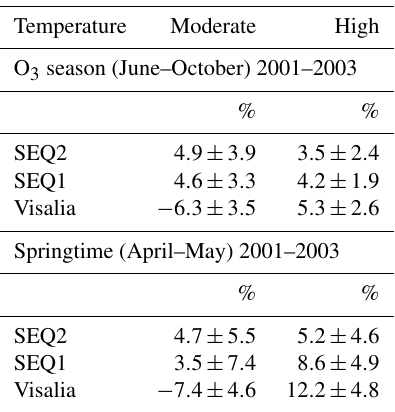
Table 1. Percent difference in afternoon (12:00–18:00LT) O x or O 3 on weekdays and weekends calculated as ( O x, weekday − O x, weekend )/ O x, weekday in Visalia, SEQ1, and SEQ2 in 2001–2003 on moderate and high temperature days. Errors are reported as stan- dard errors of the mean. Temperature Moderate